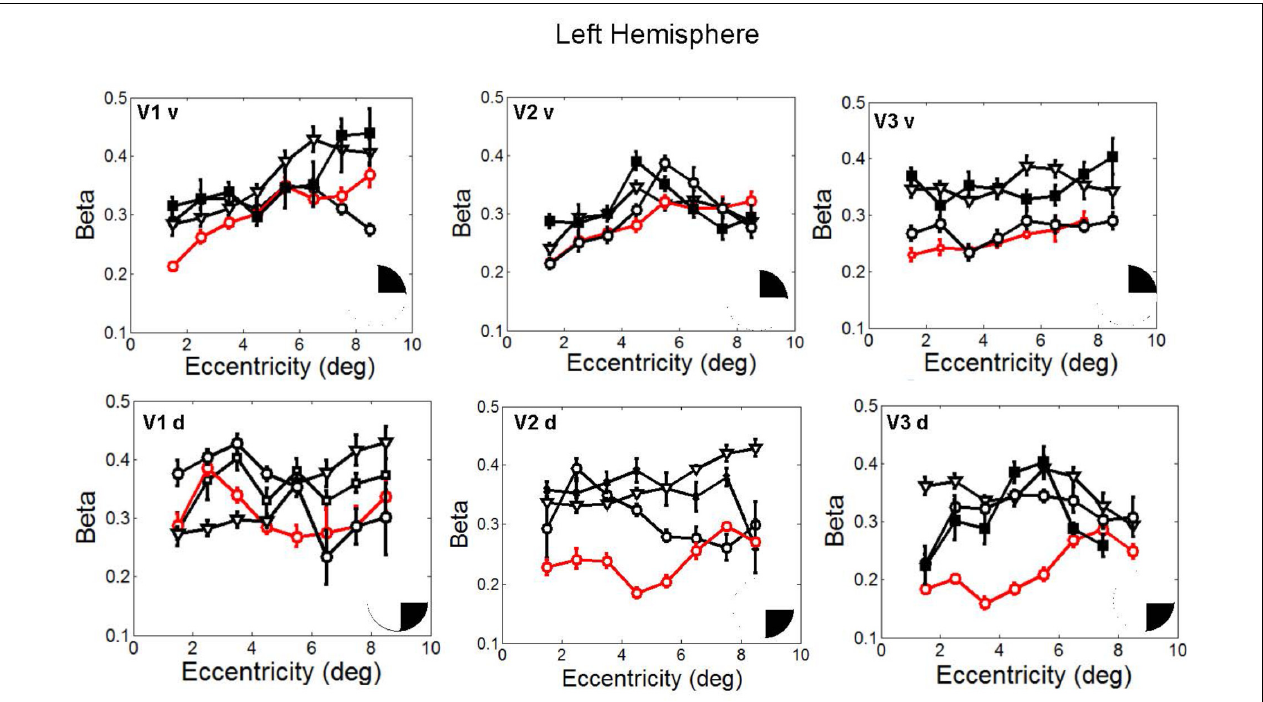
FIGURE 7 | Response amplitude ( β ) estimates plotted against eccentricity for the ventral and dorsal early visual areas. Red color corresponds to CW, black color, to the three controls. Symbols denote the mean in each eccentricity band. Error bars denote 1 standard error of the mean B. Response amplitude estimates for CW’s ventral and dorsal visual areas. Responses from the dorsal areas correspond to the blind visual